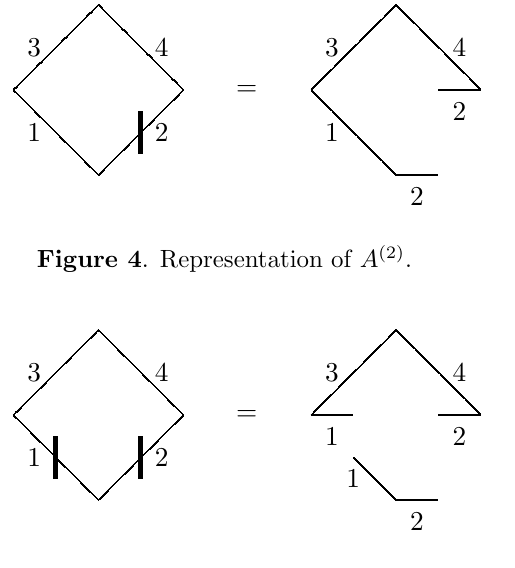
Figure 5 . Representation of A (12)